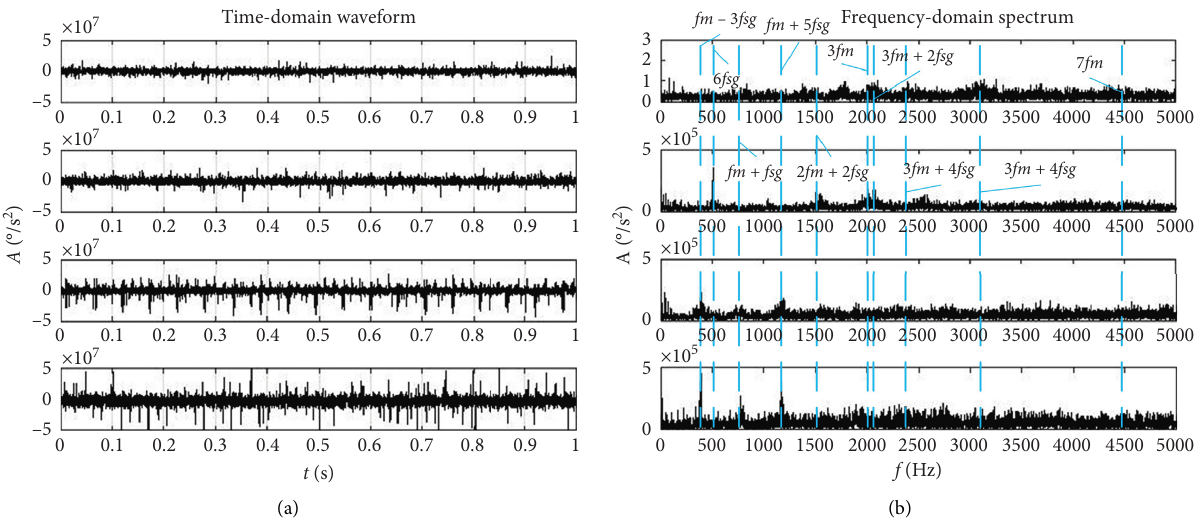
Figure 8: Angular acceleration of sun gear for different crack cases. (a) Time-domain waveform. (b) Frequency-domain